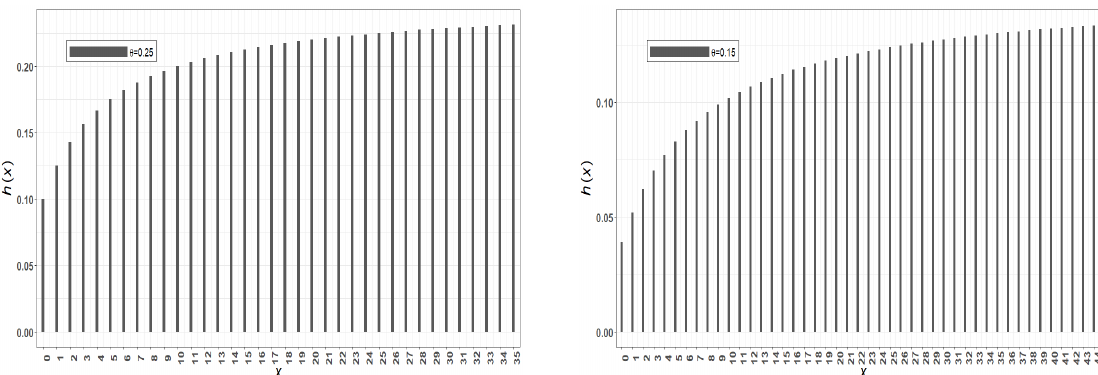
Figure 2. Plots of the hazard rate (HR) function of the NDL distribution.